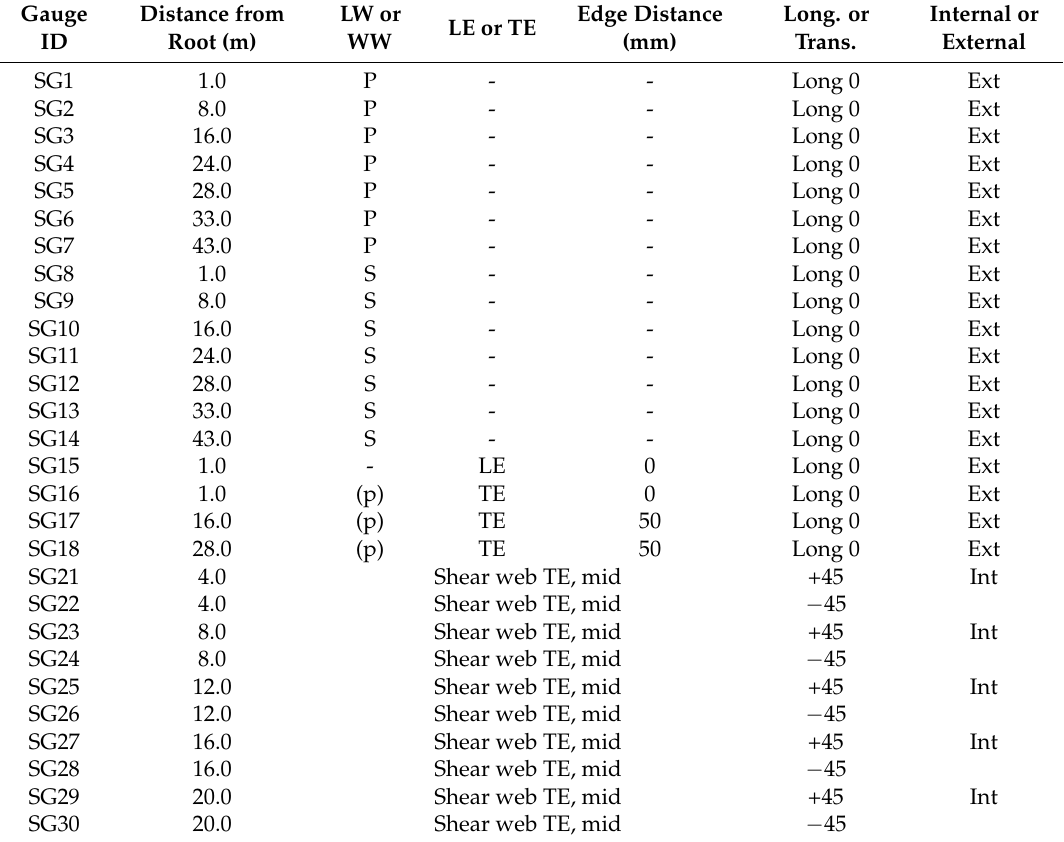
Table 1. Locations and position of strain gauges on the blade.